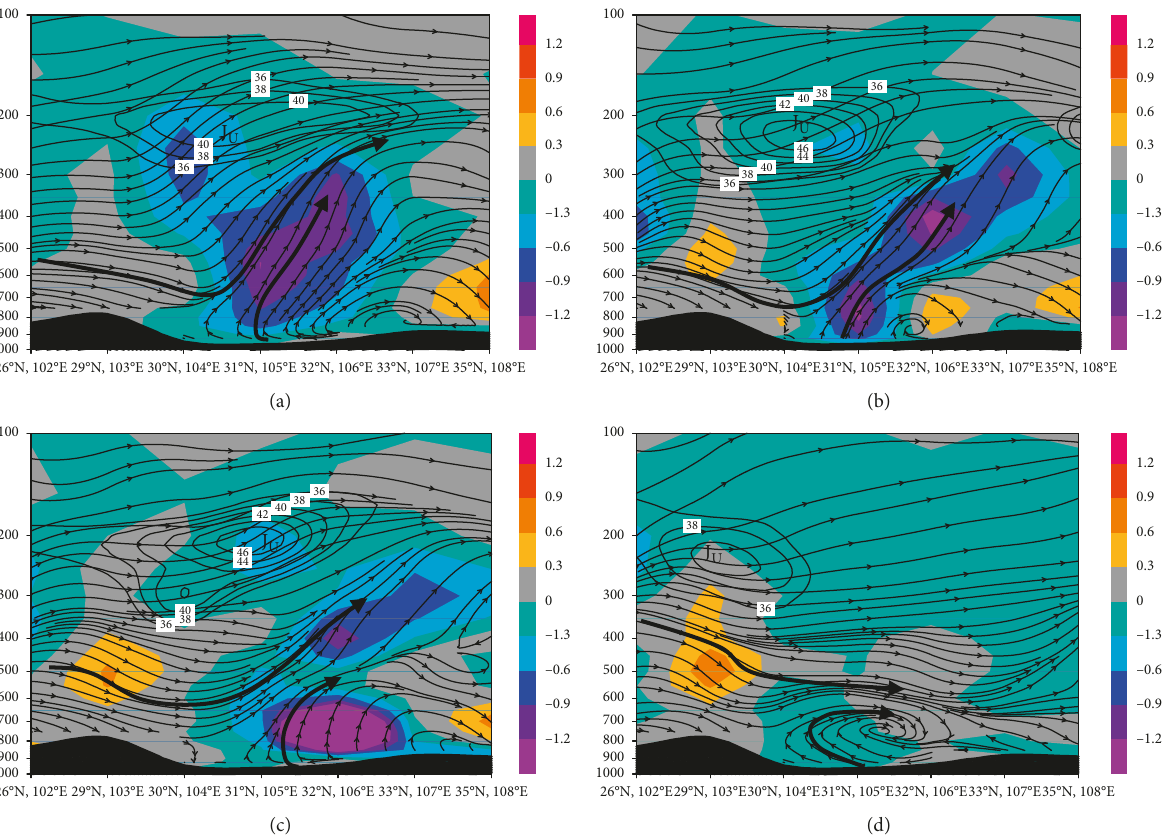
Figure 7: Cross section of vertical circulation along line A-A ′ in Figure 6(a), in which the solid contours are the horizontal wind speed (“J U ” is the ULJ axis), the shaded area is the vertical velocity (10 − 2 Pa · s − 1 ), the stream line is the synthetic circulation of both horizontal wind (m · s − 1 ) and vertical velocity (10 − 2 Pa · s − 1 ), the thick solid lines with arrows are the airflow direction, and the black areas are the terrain, at (a) 0000 UTC 27 October 2014, (b) 0600 UTC 27 October 2014, (c) 1200 UTC 27 October 2014, and (d) 0000 UTC